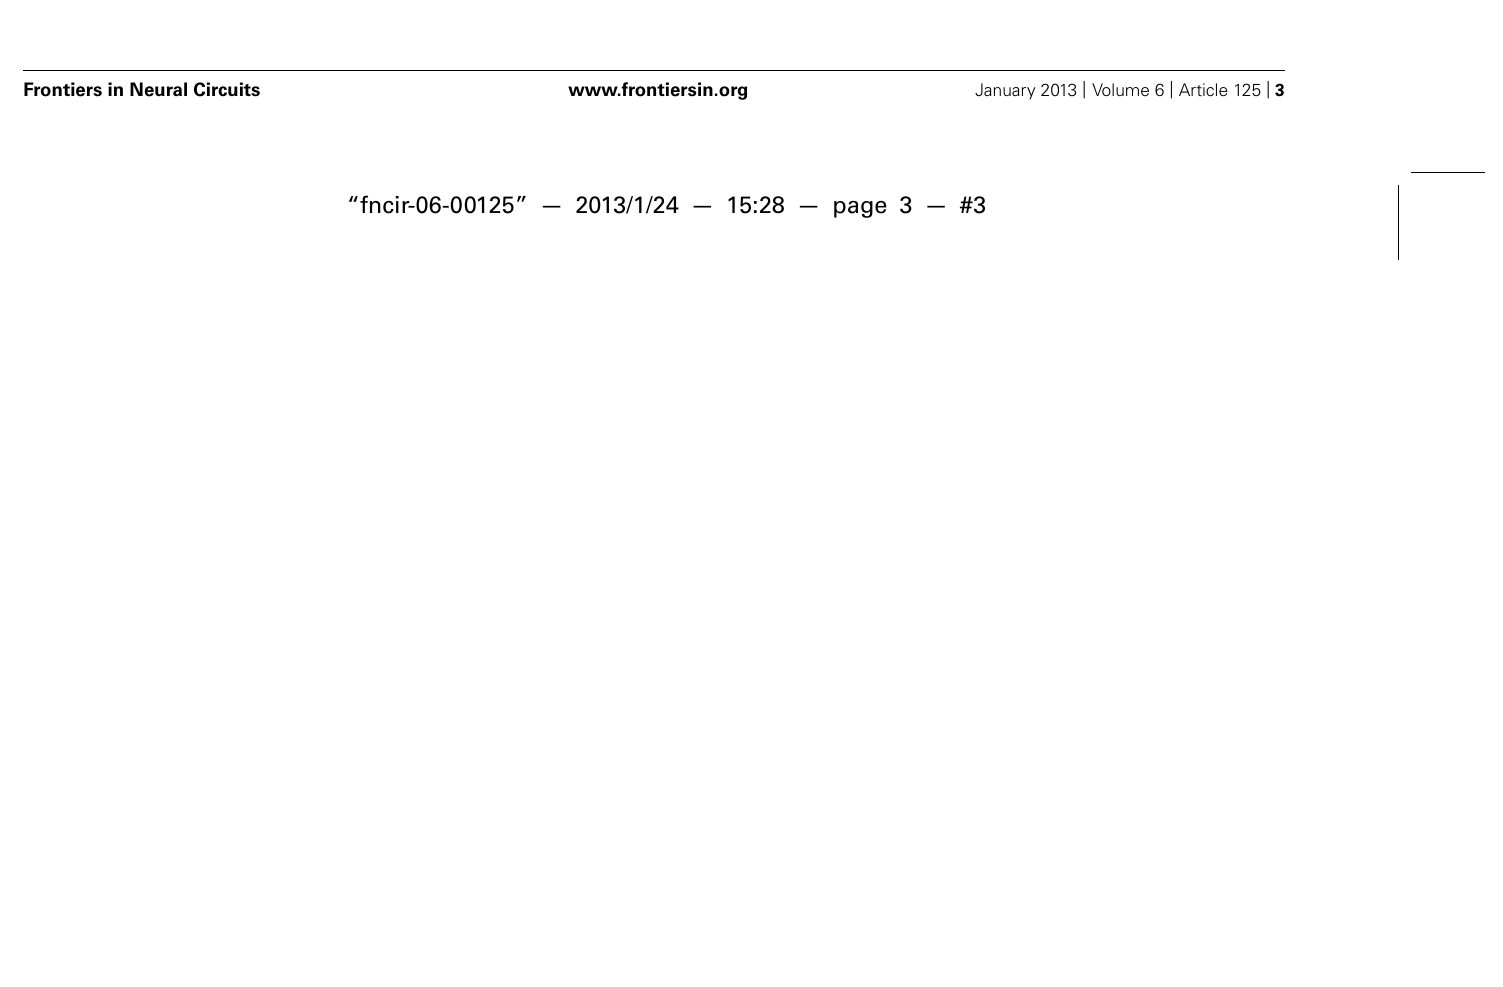
FIGURE 1 | Existing methods for simultaneous behavior and neural recording. (A) a fly in a flight arena while whole-cell recordings are made fromVS cells (from the Dickinson lab, Maimon etal., 2010, reproduced with permission). (B) A mouse walking on a suspended ball through a virtual reality environment while its brain is two-photon scanned (from theTank lab, Dombeck etal., 2007, reproduced with permission; Harvey etal., 2009). (C) Diagram illustrating the closed-loop experimental setup in a larval zebrafish. A moving grating is shown to a head-restrained larva (the grating speed is represented by the red arrow) and its behavior is